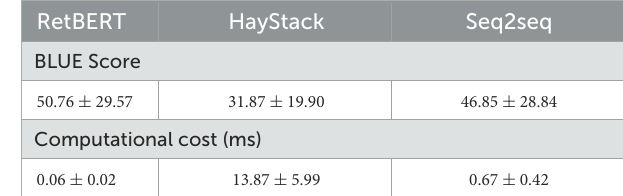
TABLE 2 Quantitative performance of the evaluated retrieval models RetBERT, HayStack, and